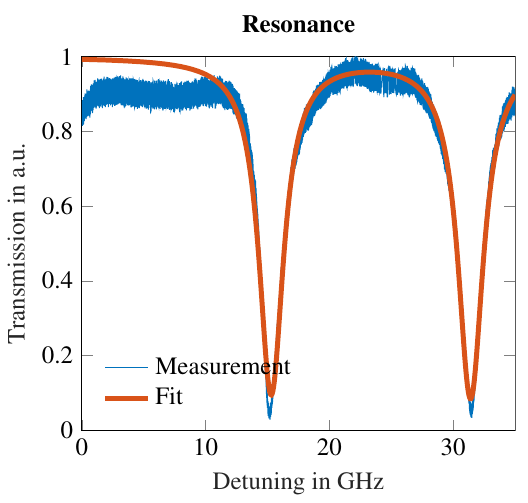
Figure 3: Fine scan of the resonance compared to a Lorentzian fit with a spectral window of 35 GHz